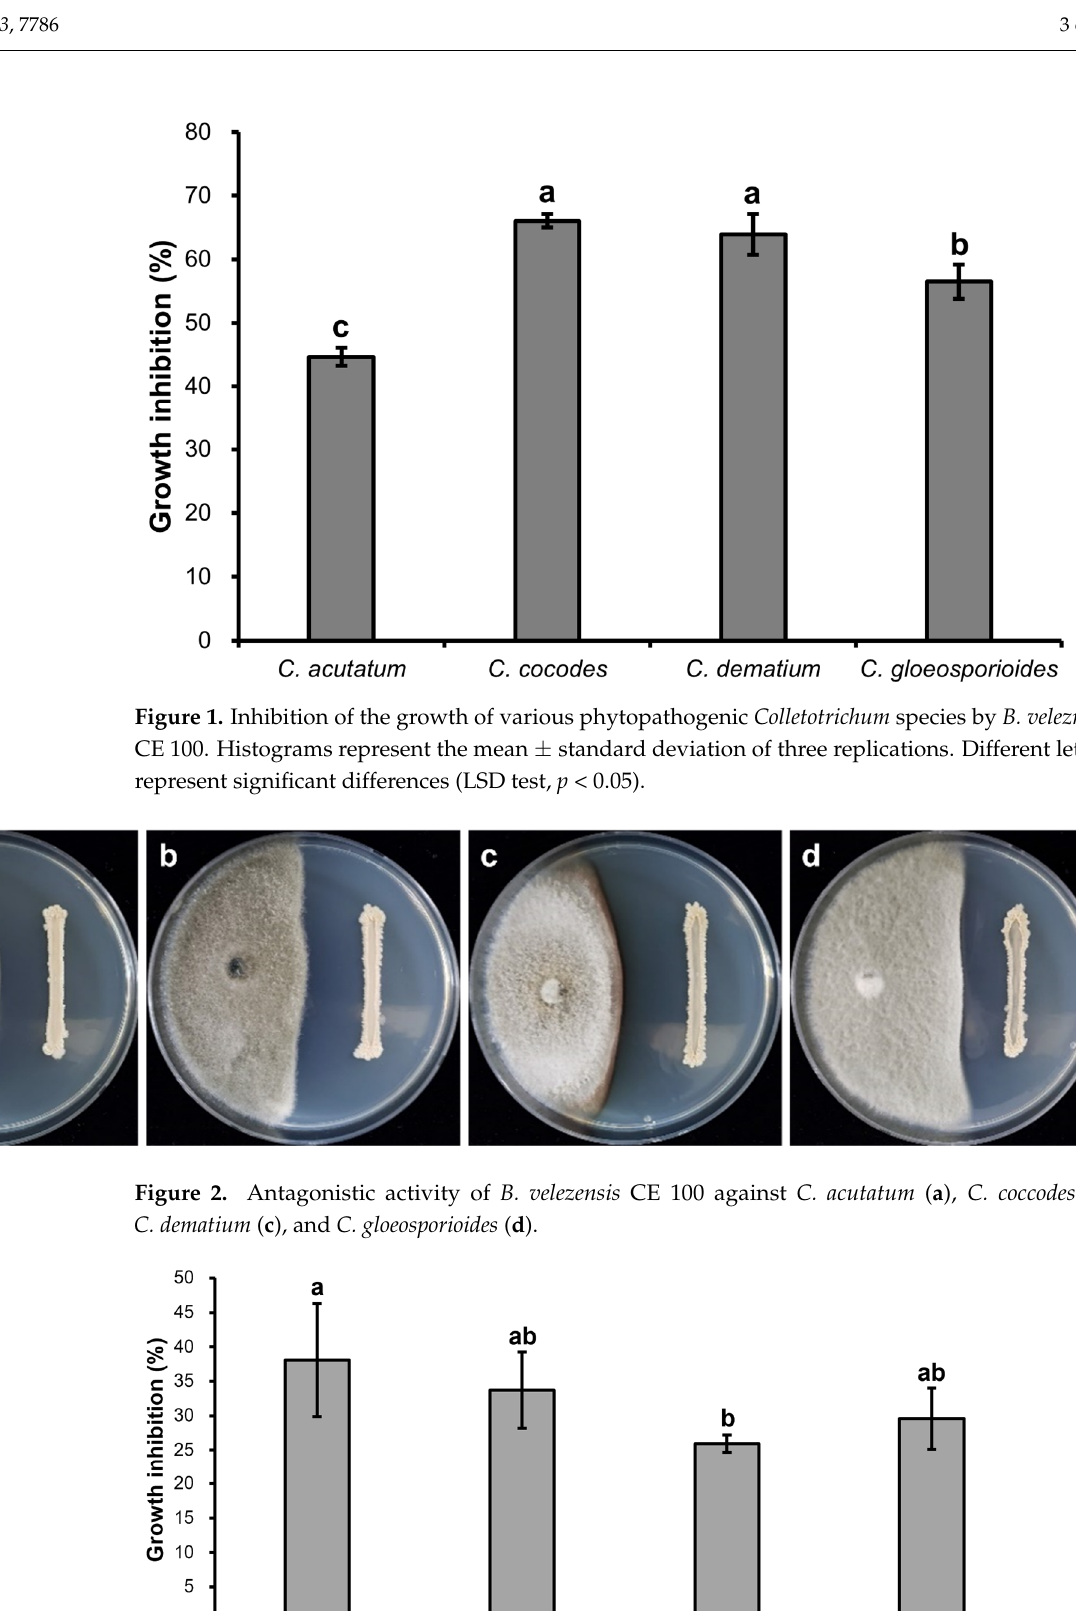
Figure 4. Morphology of VOC-affected hyphae of C. acutatum ( a ), C. coccodes ( b ), C. dematium ( c ), and C. gloeosporioides ( d ) compared with morphology of the controls. (scale bar = 25 μ m). 2.3. Effect of Chloroform Crude Extract on Mycelial Growth and Hyphal Morphology of the Colletotrichum Species As shown in Figure 5, the chloroform crude extracts of strain CE 100 affected the growth of tested fungi. The inhibitory effect was concentration-dependent and increased with increasing concentration of the chloroform crude extract. The highest inhibition rates (43.83% against C. acutatum , 68.69% against C. coccodes , 59.05% against C. dematium , and 49.86% against C. gloeosporiodes ) were observed when the fungal pathogens were treated with the highest crude extract concentration (1000 mg/L). However, the highest crude extract concentration was not highly effective in controlling the growth of C. acutatum when compared to the other three fungal pathogens. Treatment with the lowest